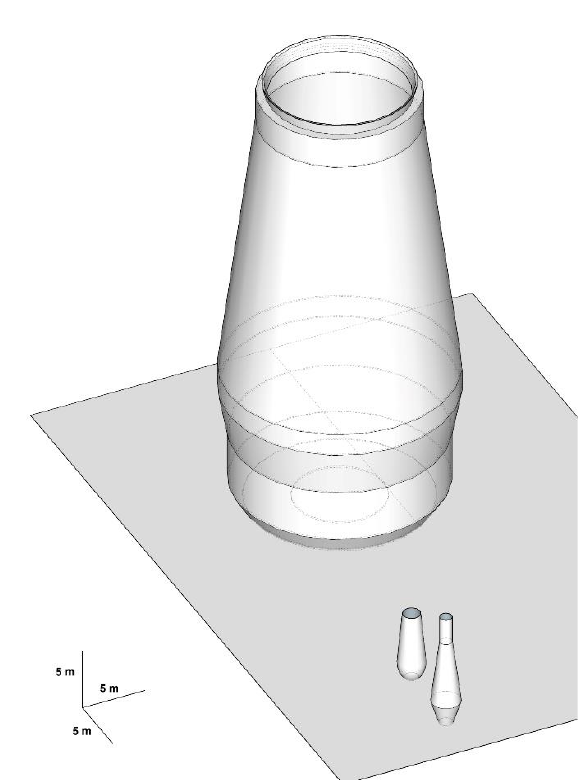
Figure 3: a contemporary blast furnace and the ones at Ipanema factory at the same scale: the height of the blast furnace expanded four times over time to accommodate the rise in daily production, while the diameter of the base increased 28 times (graphic elaboration by the authors based on the work of Prof. Landgraf research